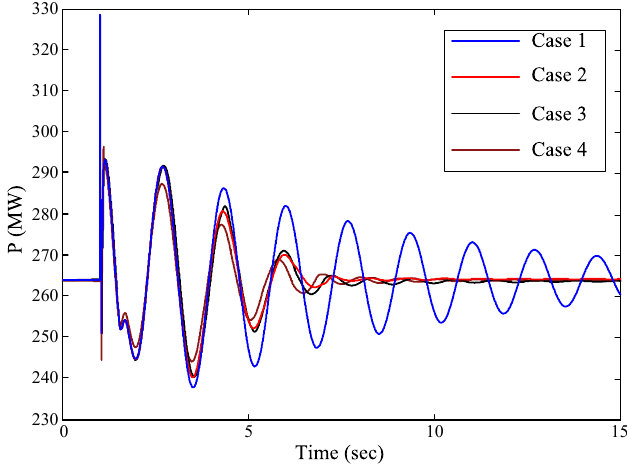
Figure 11. Transmission power between area I and area II. Case 1 corresponding to without damping controller; Case 2 and Case 3 corresponding to the damping controller with reactive power feedback and voltage feedback control scheme active at the same time, respectively; Case 4 corresponding to the voltage feedback control scheme with damping